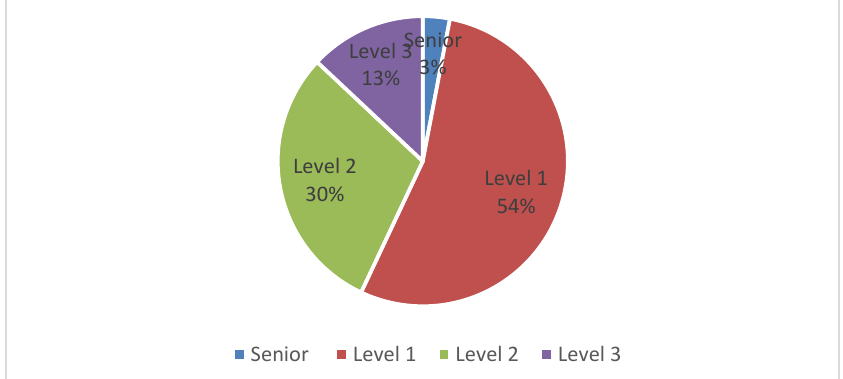
Fig. 1. Distribution of